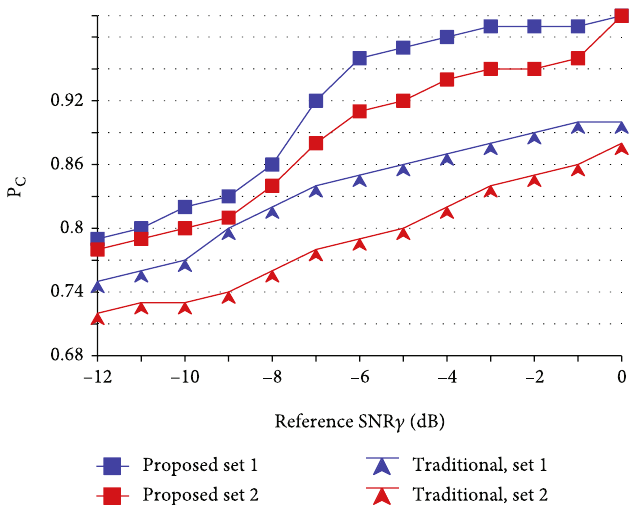
Figure 4: The recognition probability of the algorithm based on the likelihood function on the signal-to-noise ratio.